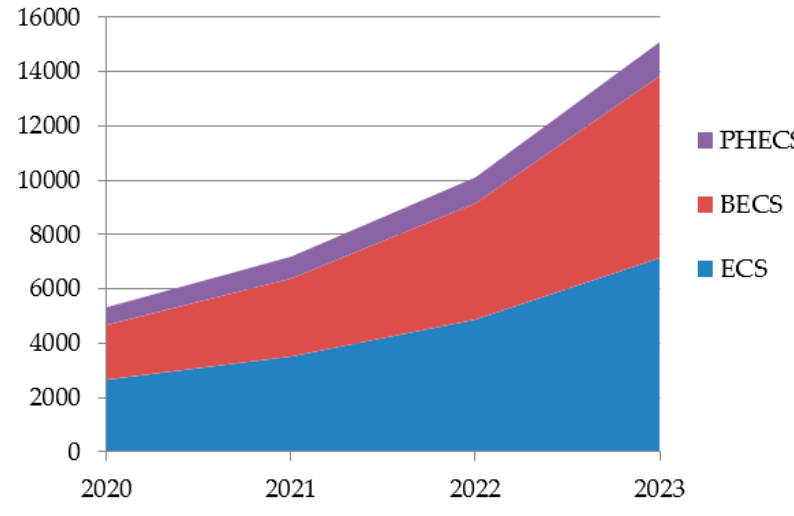
Figure 3. Forecasted electric car sale (thousand in millions).